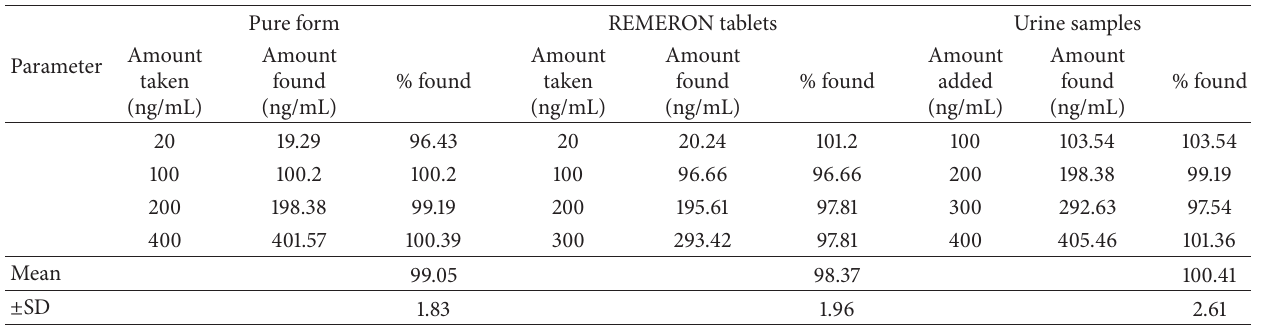
Table 2: Results of the determination of MRZ in pure form, REMERON tablets (Lot number 783147), and urine samples.